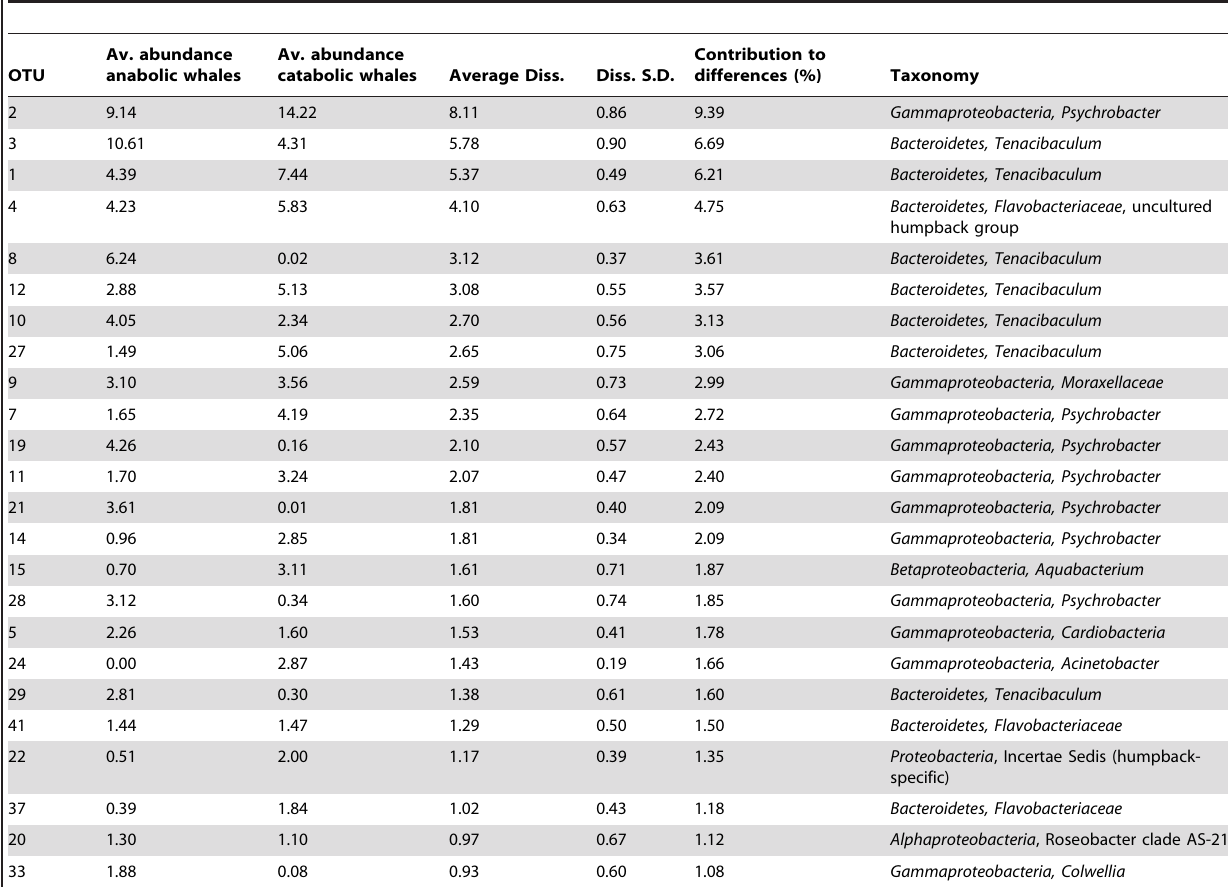
Table 4. Results of SIMPER analysis describing 97% similarity grouped OTUs contributing to the differences between the whales with anabolic and catabolic metabolisms ( . 1% contribution